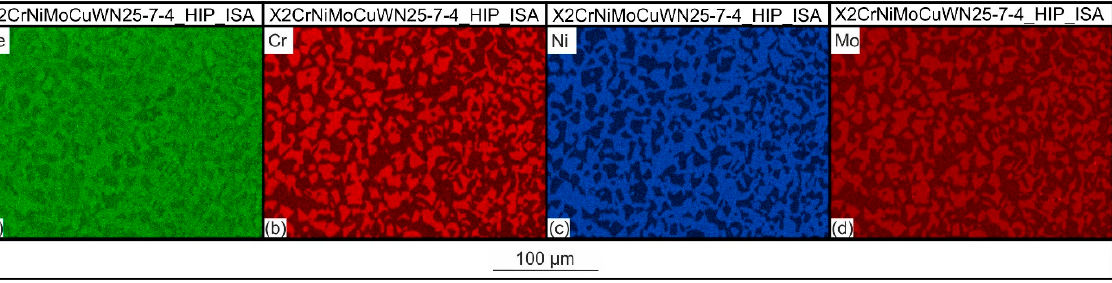
Figure 9. Element distributions of the X2CrNiMoCuWN25-7-4_HIP_ISA steel determined by EDS: ( a – d ).